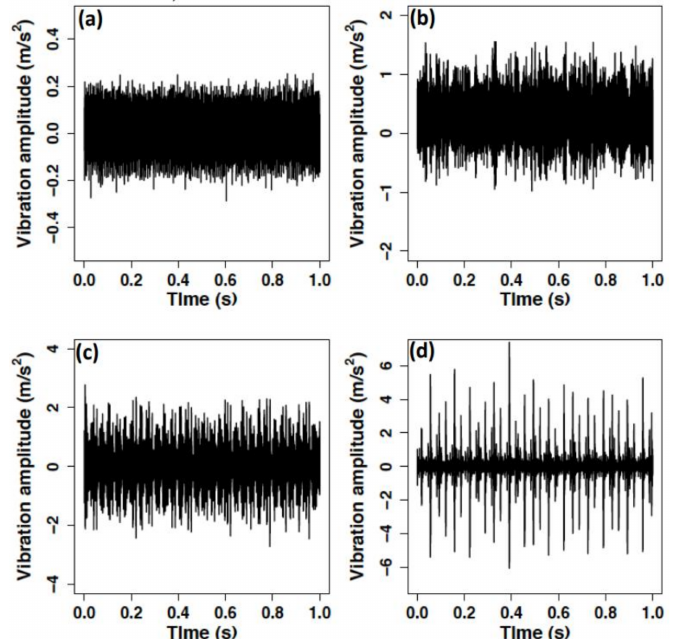
Figure 4. Vibration signals from bearings under different health conditions: ( a ) normal, ( b ) ball fault, ( c ) inner race fault, ( d ) outer race